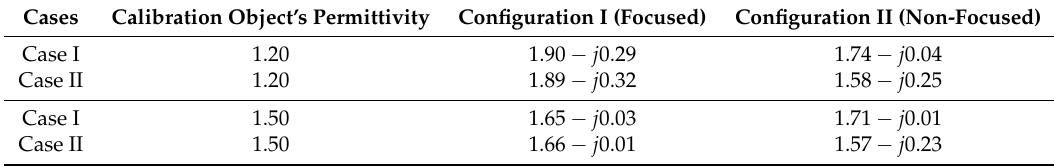
Table 1. The reconstructed OI’s permittivity for Cases I and II under the two